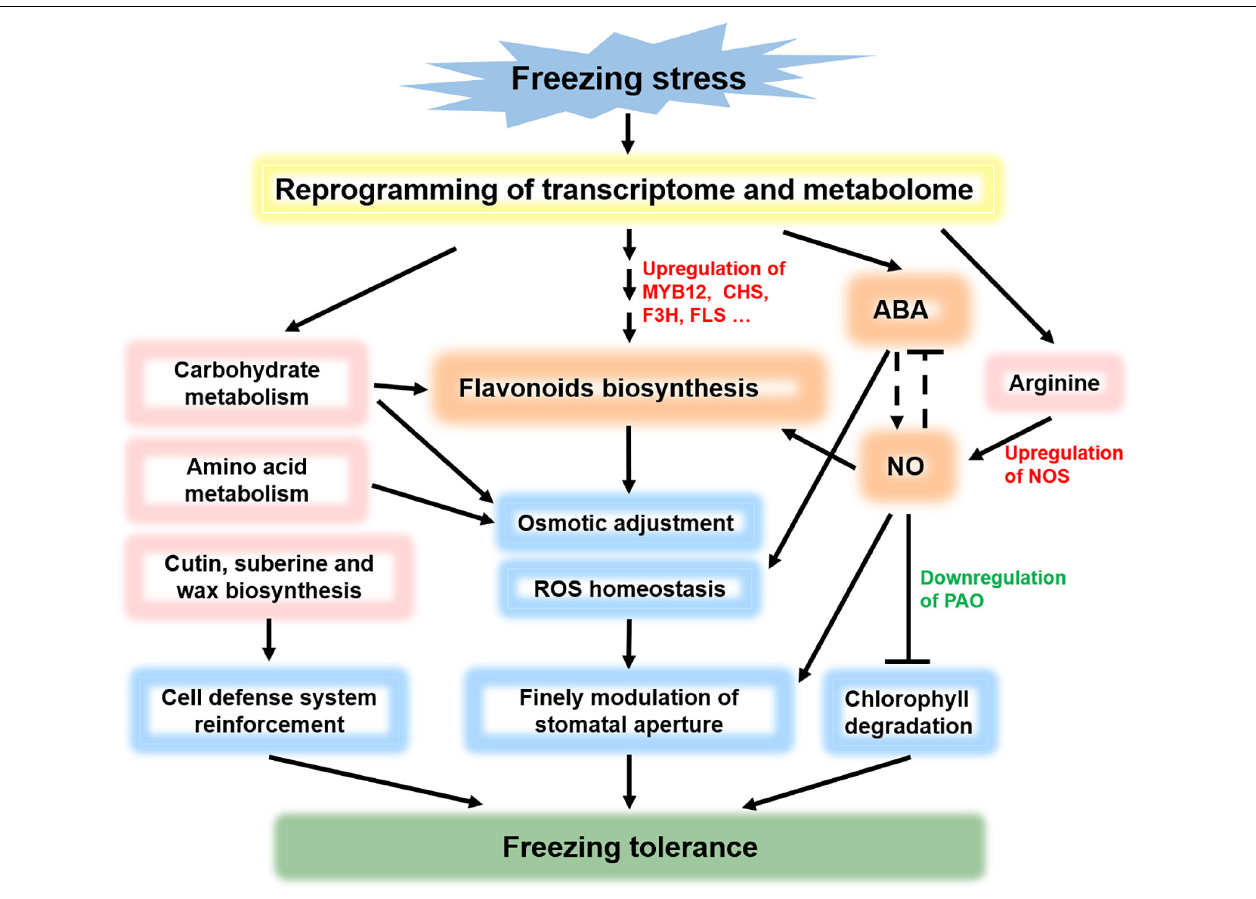
FIGURE 7 | Schematic model of flavonoid, ABA, and NO comodulated freezing tolerance. Under freezing stress, the transcriptome and metabolome are reprogrammed, causing significant responses in flavonoid biosynthesis, signal transduction (including ABA and NO signals), carbohydrate metabolism, amino acid metabolism, and cutin, suberin, and wax biosynthesis. Osmotic and reactive oxygen species (ROS) are adjusted to maintain homeostasis, and the cell defense system is reinforced. Flavonoids, ABA, and NO form a regulatory network and play a synergistic effect in osmotic adjustment, ROS homeostasis, and stomatal closure. Meanwhile, PAO is downregulated by NO to prevent Chl degradation. In summary, the network formed by the above physiological and biochemical pathways comodulates the freezing tolerance in L. spicata